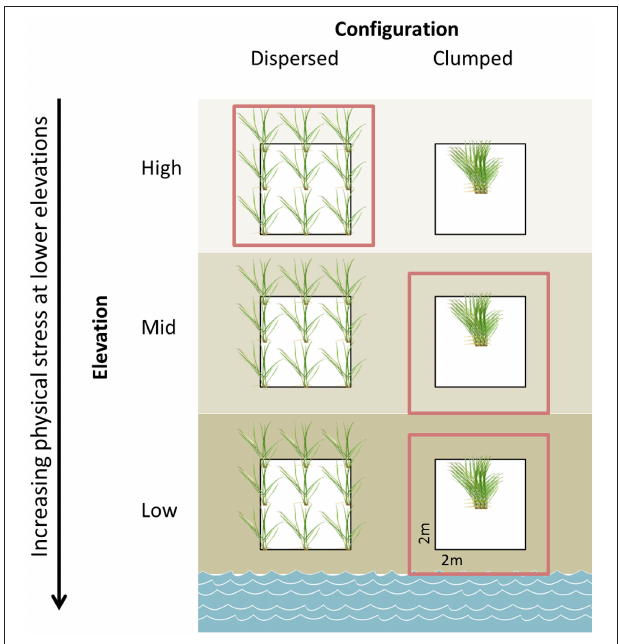
FIGURE 6 | Visual depiction of clumped vs. dispersed restoration designs in a salt marsh with increasing physical stress along an elevation gradient. Red boxes indicate the more efficient method of planting. Created by Amanda